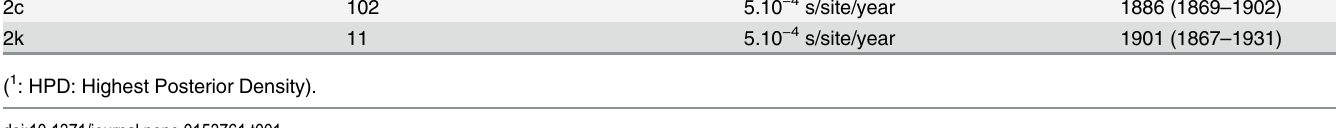
Table 1. t MRCA estimations using the NS5B region for the HCV- 2c and HCV-2k in Tunisia. HCV